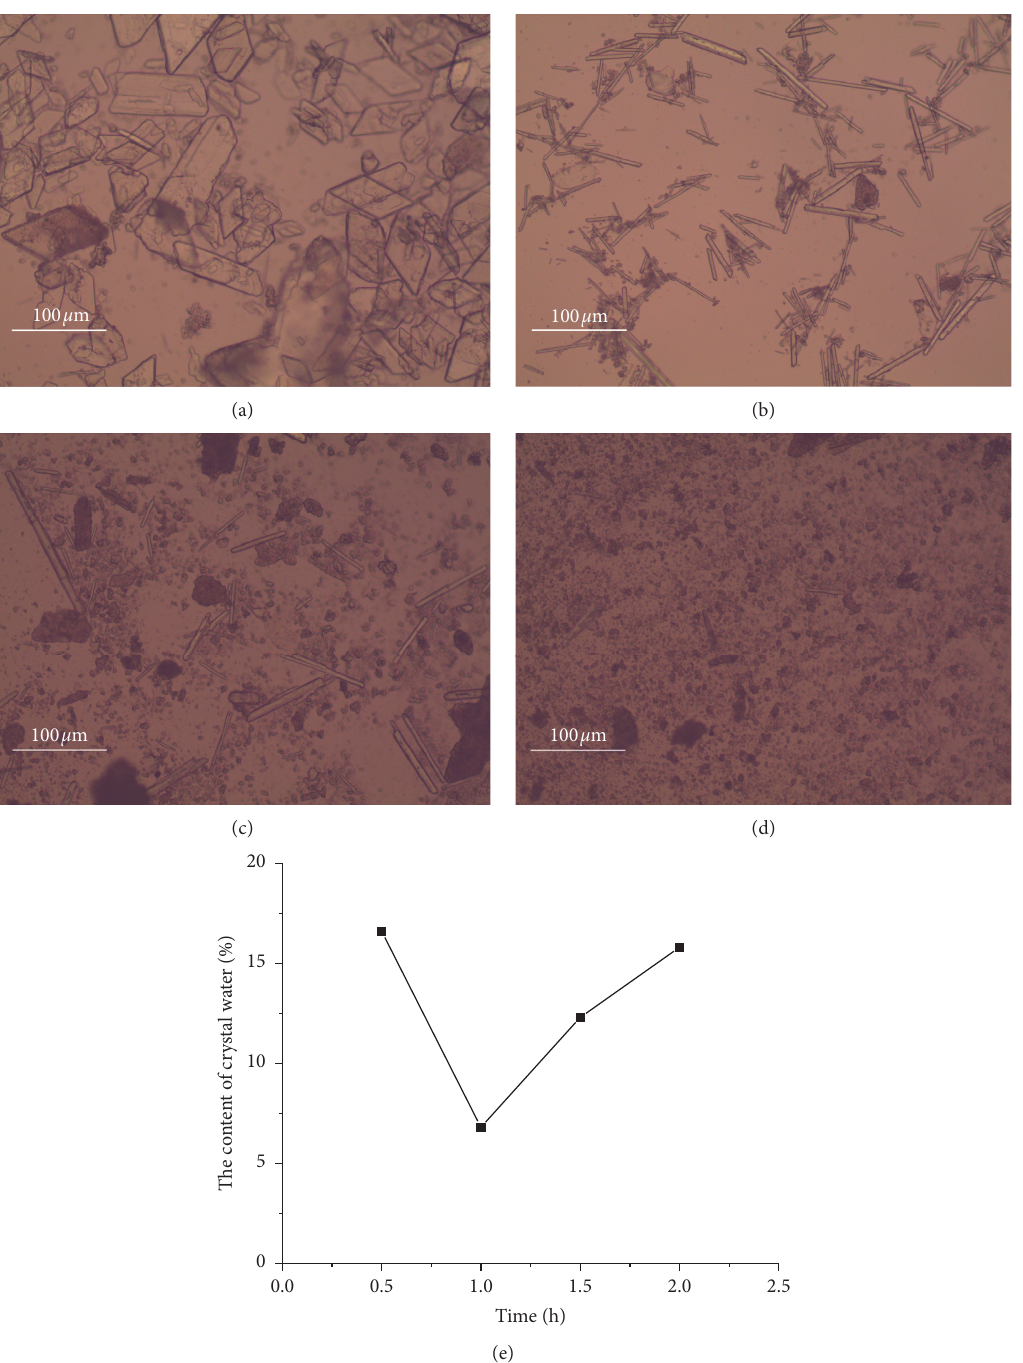
Figure 2: Polarizing microscope photo and changes in crystal water content (e) without a modifier at a heating temperature of 100 ° C for 2h: (a) 0.5h; (b) 1h; (c) 1.5h; (d)